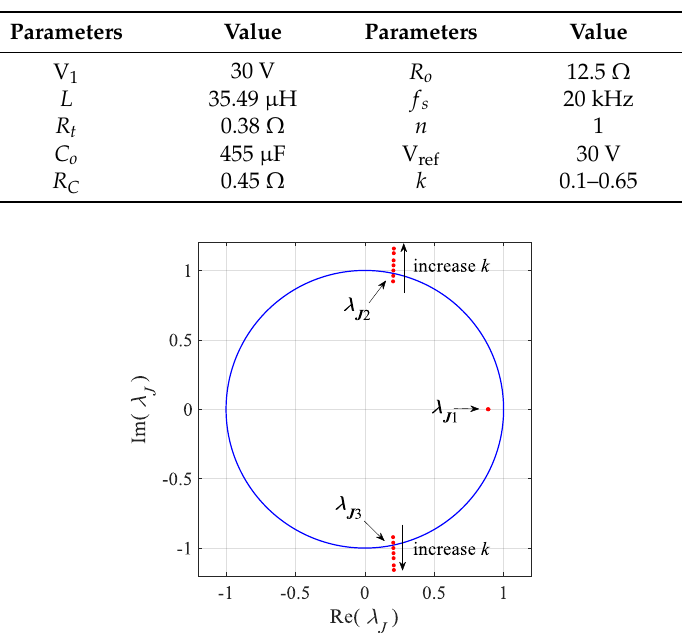
Table 1. System parameters of the DAB converter.